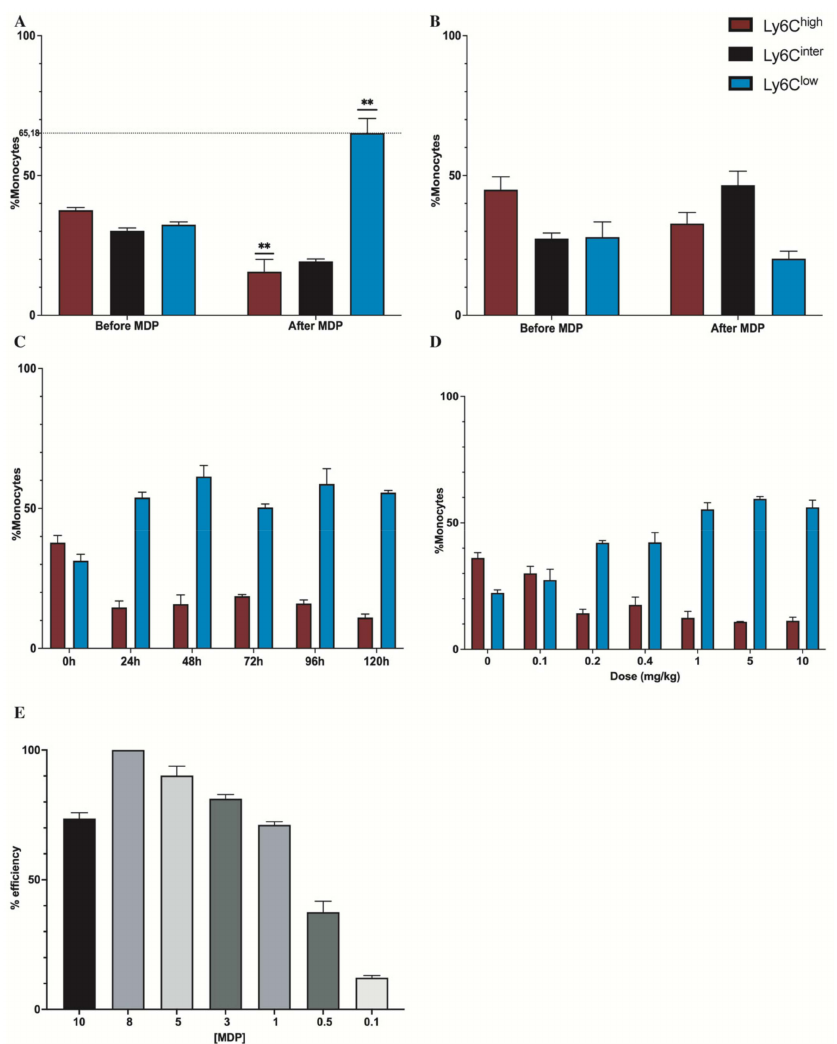
Figure 2. MDP triggers the monocyte conversion in an NOD2-dependent manner. ( A ): Flow cytometry analysis of monocyte subsets in blood on ( A ) WT and ( B ) NOD2 − / − , before and after administration of an injection of MDP each day on 3 consecutive days at 10 mg/kg. ( C ): Flow cytometry analysis of monocyte subsets in the blood before MDP administration 0 to 120 h post-induction. ( D ): Dose response after induction of MDP at 0, 0.1, 0.2, 0.4, 1, 5, and 10 mg/kg on WT mice. ( E ): Results of MDP are dose dependent on HEK-Blue™-hNOD2 cells in contact for 6 h. Data are mean ± SEM ( n = 4 animals/group). ** p < 0.01 compared to the monocyte subset population before